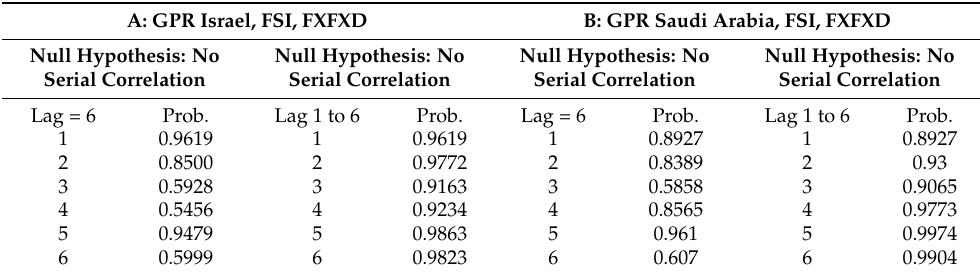
Table 11. VAR residual serial correlation with one GPR.